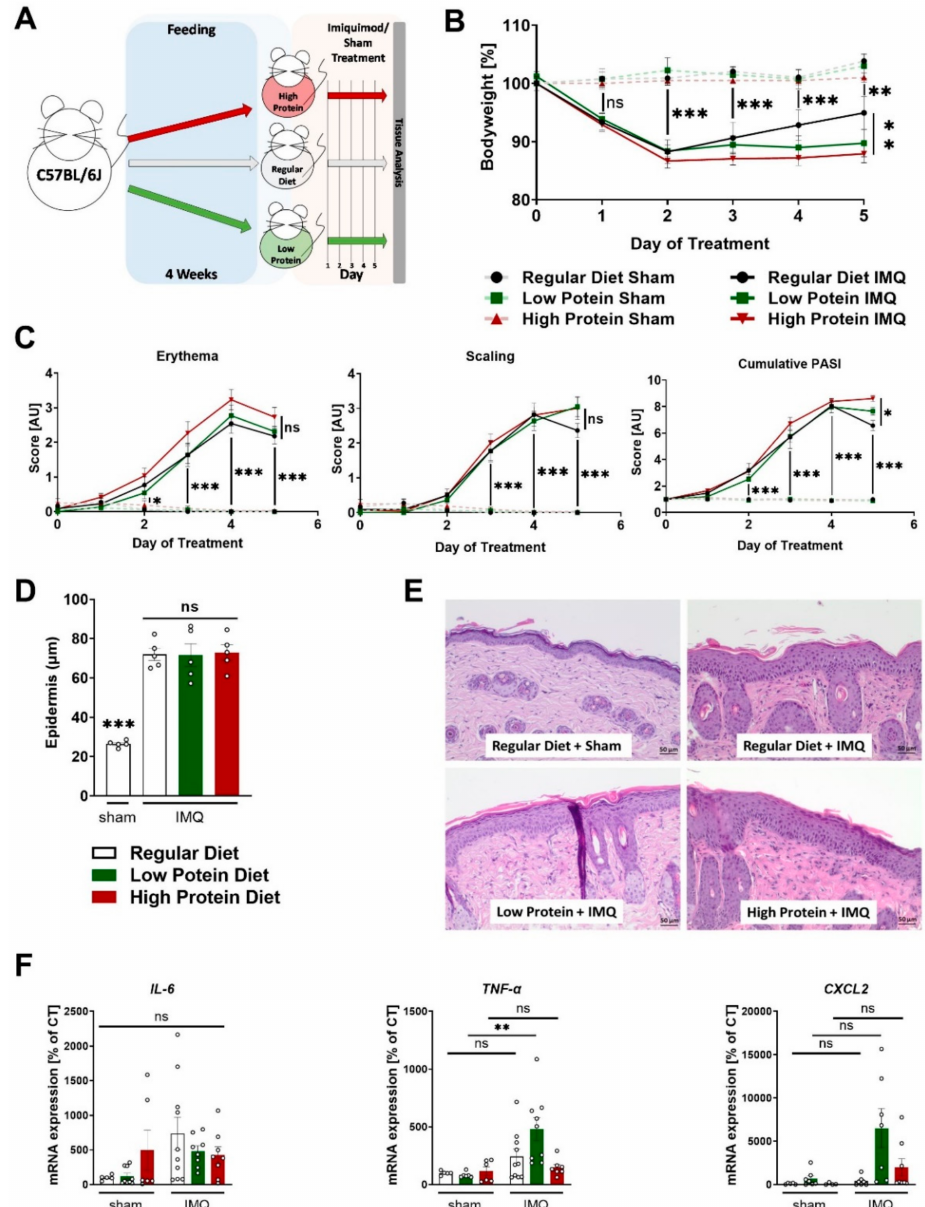
Figure 2. Modulating dietary protein only slightly affects skin inflammation in IMQ-induced psoriasis-like skin disease. ( A ) Graphic presentation of the experimental setting. ( B ) Change in bodyweight during treatment in sham or IMQ-treated animals on a regular, low, or high protein diet ( n = 4–13; 2-way ANOVA. ( C ) Scoring of the severity of skin disease during sham or IMQ-treatment in the different dietary groups. Erythema and scaling were graded, and cumulative PASI-score calculated ( n = 8–13; 2-way ANOVA). ( D ) Quantification of the thickness of the epidermal layer using H&E-stained skin sections from sham treated animals on a regular diet or IMQ-treated animals on a regular, low, or high protein diet ( n = 5; 1-way ANOVA). ( E ) Representative H&E-stained skin sections from a sham treated mouse and lesional skin of IMQ-treated animals on different diets. Scale bars equal 50 µ m. ( F ) Expression of IL-6 , TNF- α , and CXCL2 mRNA in skin of sham or IMQ-treated animals on regular, low, or high protein diet ( n = 5–10; 1-way ANOVA). Data are shown as mean ± SEM. Black asterisks show significant differences between sham and IMQ-treated mice. *** p < 0.001; ** p < 0.01; * p <